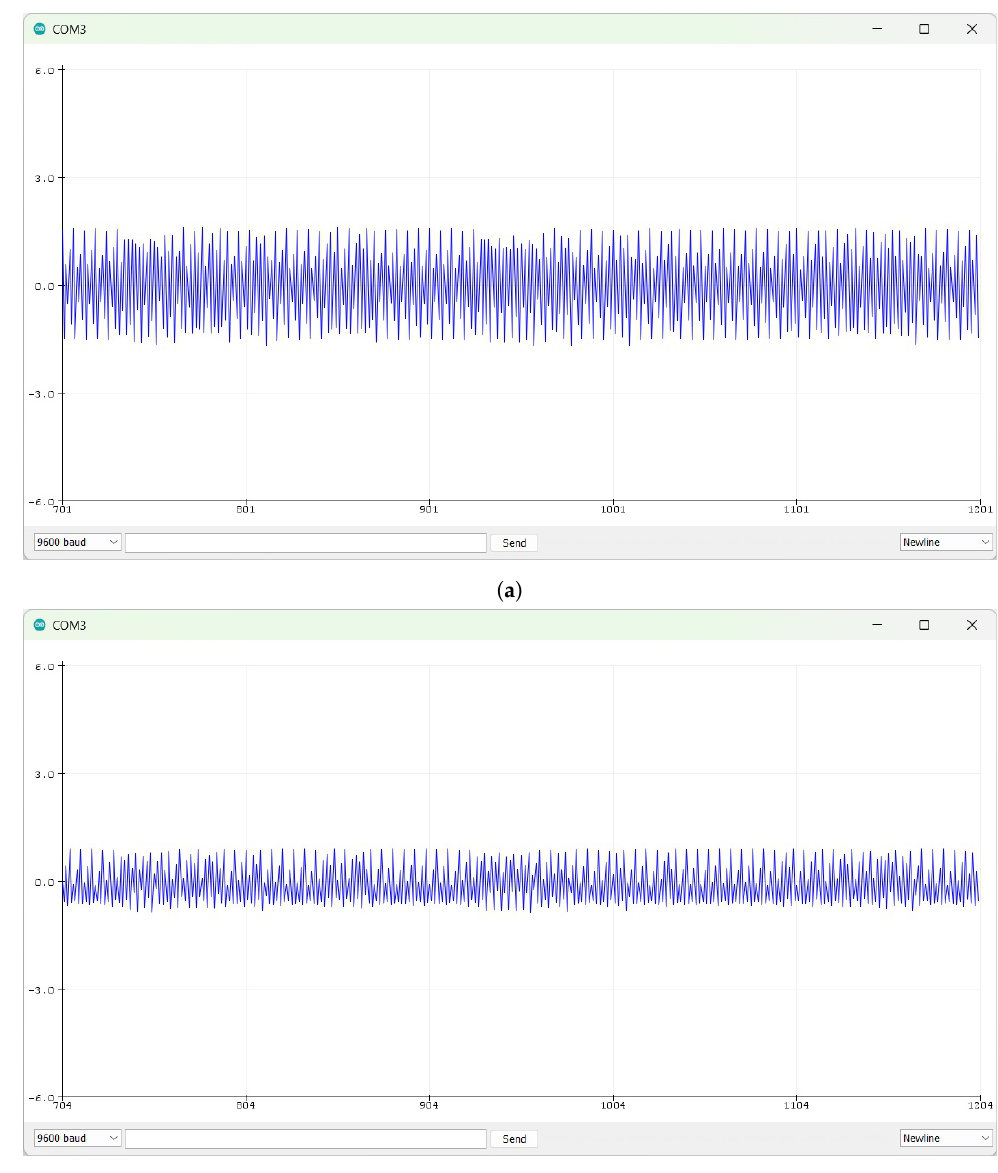
Figure 9. Captured signals of the FPFM 1 map realized with a hardware board ( a ) signal x , ( b ) signal y